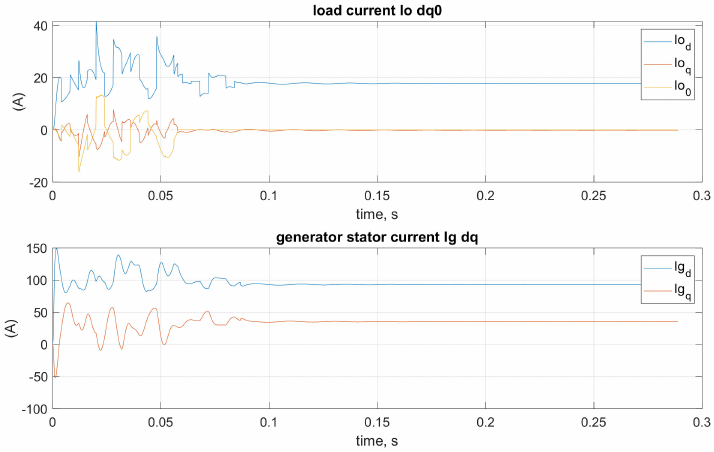
Figure 29. Load current I 0 and generator stator current I g waveforms in dq coordinates for protection